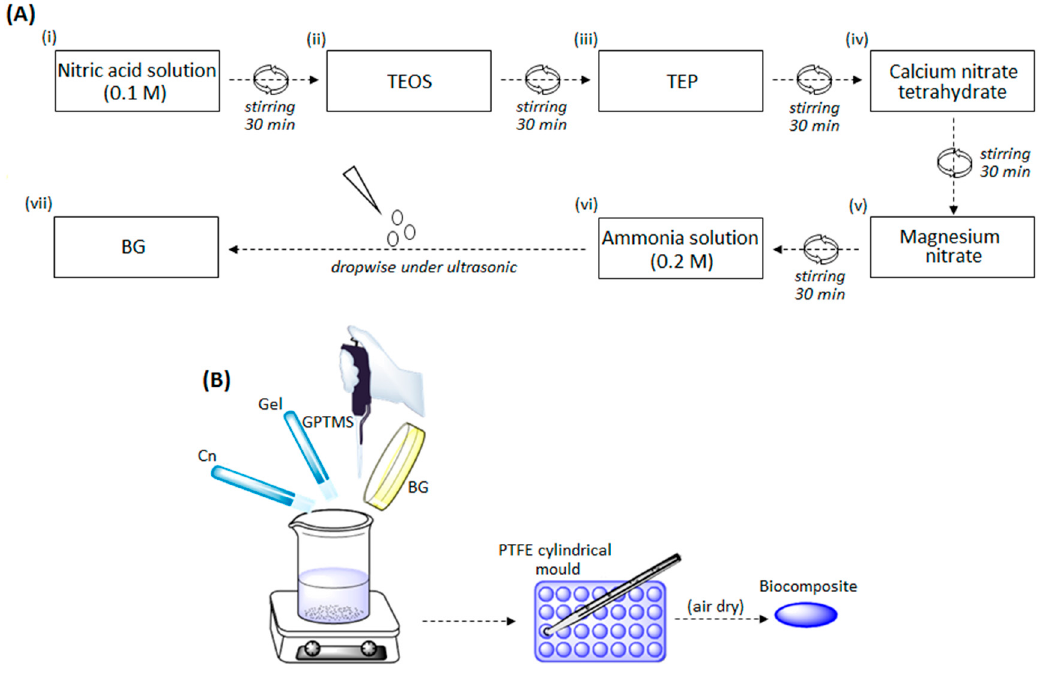
Figure 1. Schematization of the sol–gel process ( A ) and of the composites preparation method ( B ). Table 1. Bioactive glass (BG) and BG-polymers chitosan (Cn) or gelatin (Gel) composites settlement. Cn 1 Gel 1 GPTMS 2 Specimen Code Paste